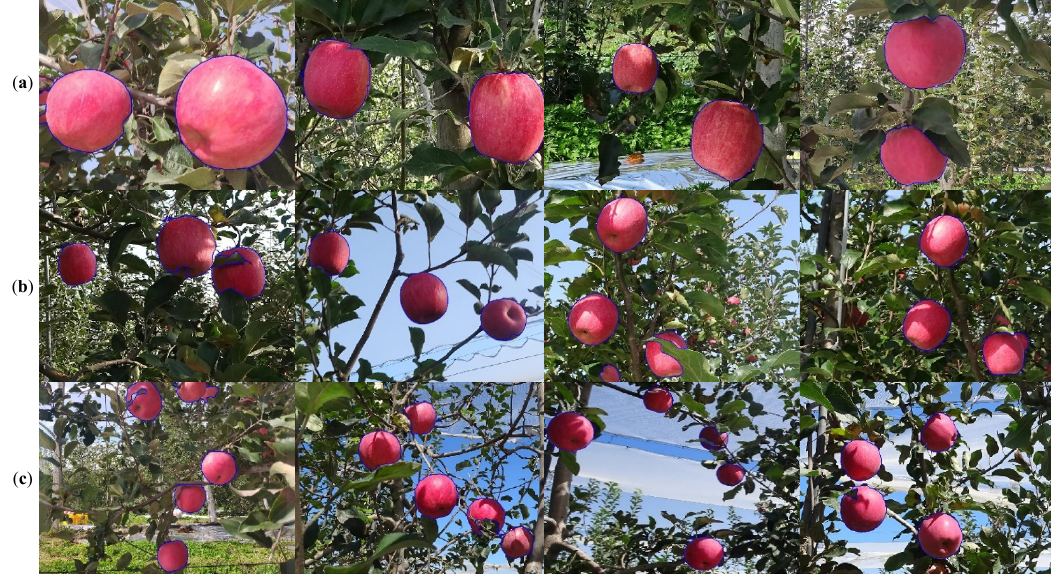
Figure 8. Segmentation results for apple images: ( a ) double-fruit, ( b ) triple-fruit, and ( c ) multiple fruit.